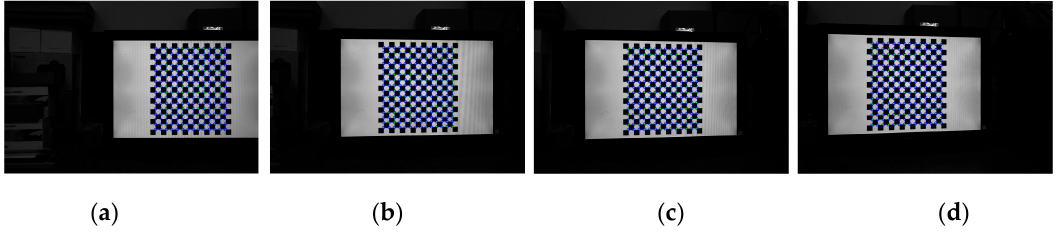
Figure 16. The checkerboard images of ( a ) 0°; ( b ) 6°; ( c )9°; ( d ) 12°.